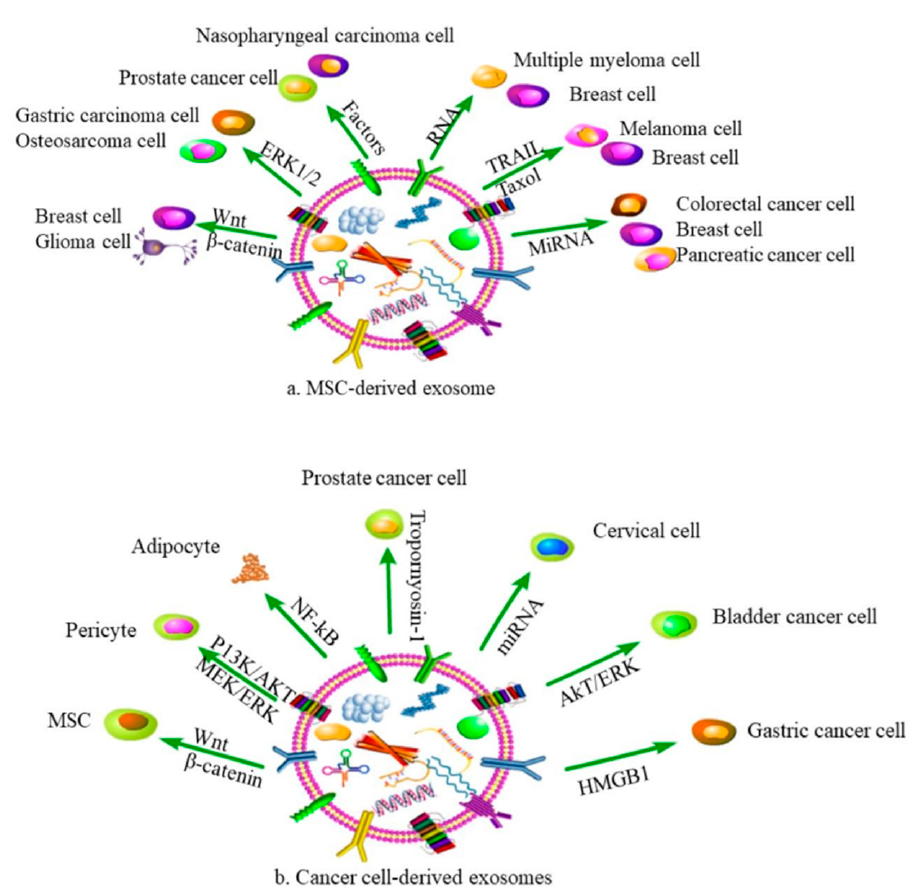
Figure 3. Effects of exosomes from different sources on cancers. ( a , b ) respectively show that exosomes from MSCs and cancer cells affect various cancers processes through different inclusions.